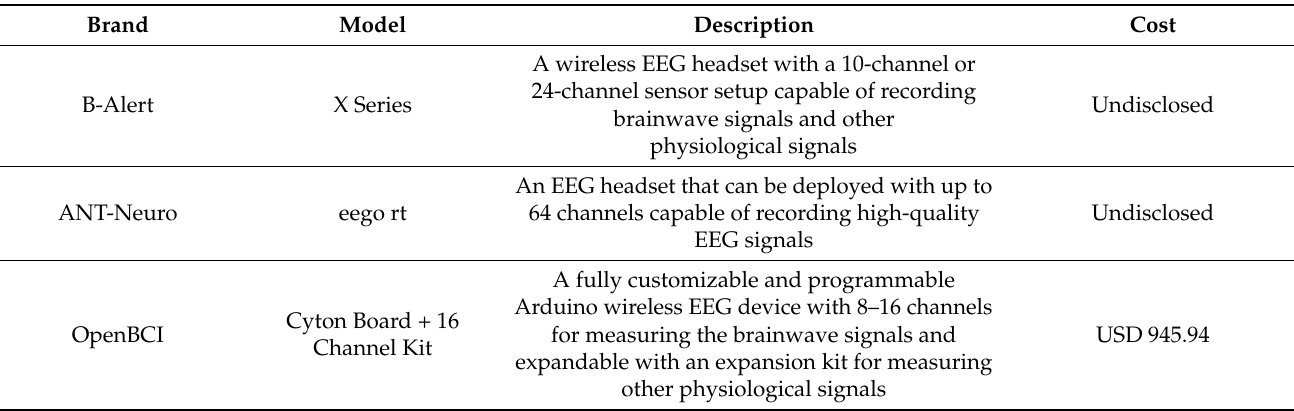
Table 2. Breakdown of EEG headsets details and